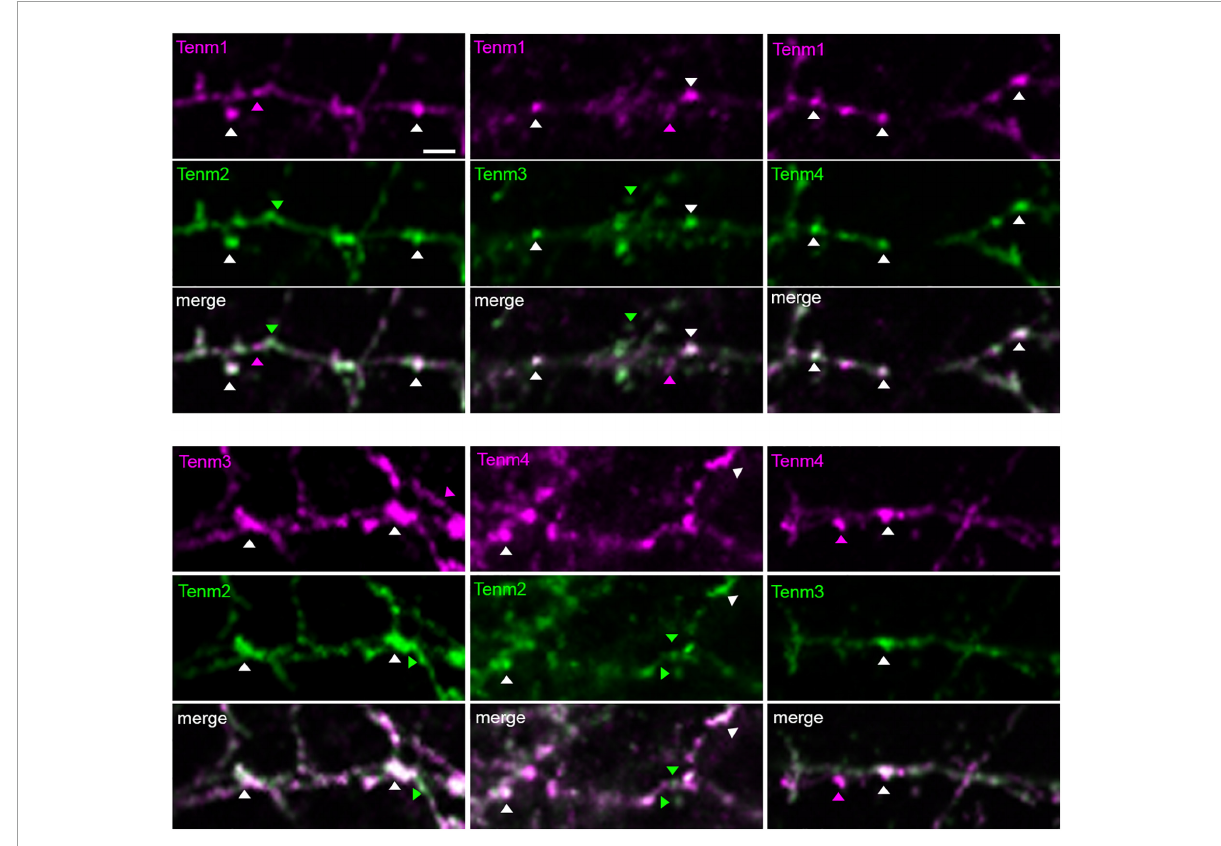
FIGURE7 Different teneurin paralogues show overlapping localisation when expressed together in dissociated neurons. EGFP- and tagRFP-tagged teneurin paralogues co-transfected in primary neuronal cultures show partial co-localisation of puncta. Arrow heads show examples of puncta from individual paralogues and co-localisations. Scale bar, 20 µ